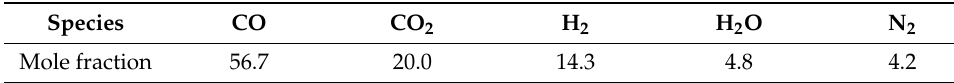
Table 4. Chemical composition of fuel gas.